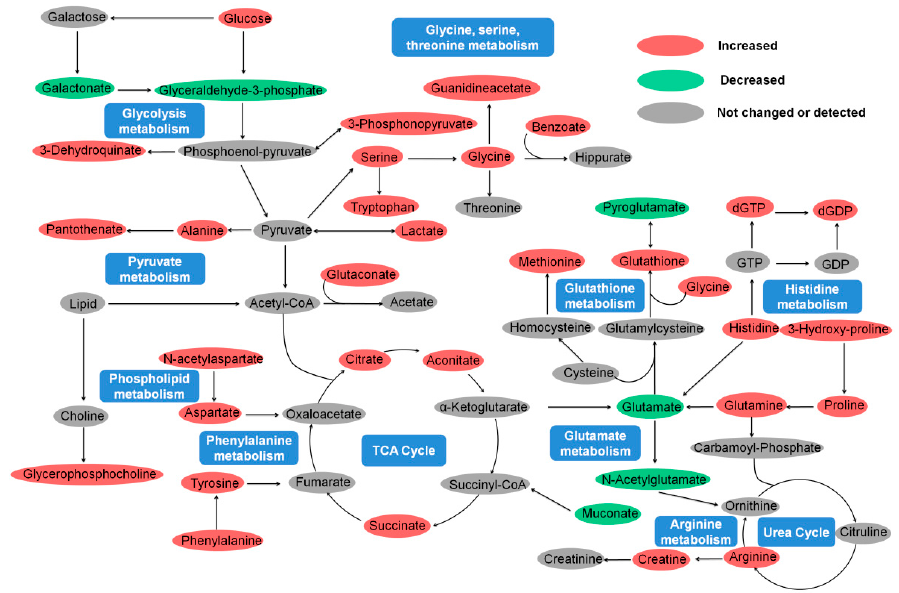
Figure 6. Perturbed pathways and fluctuant metabolites in MCF-7 cells induced by metalaxyl enantiomers.